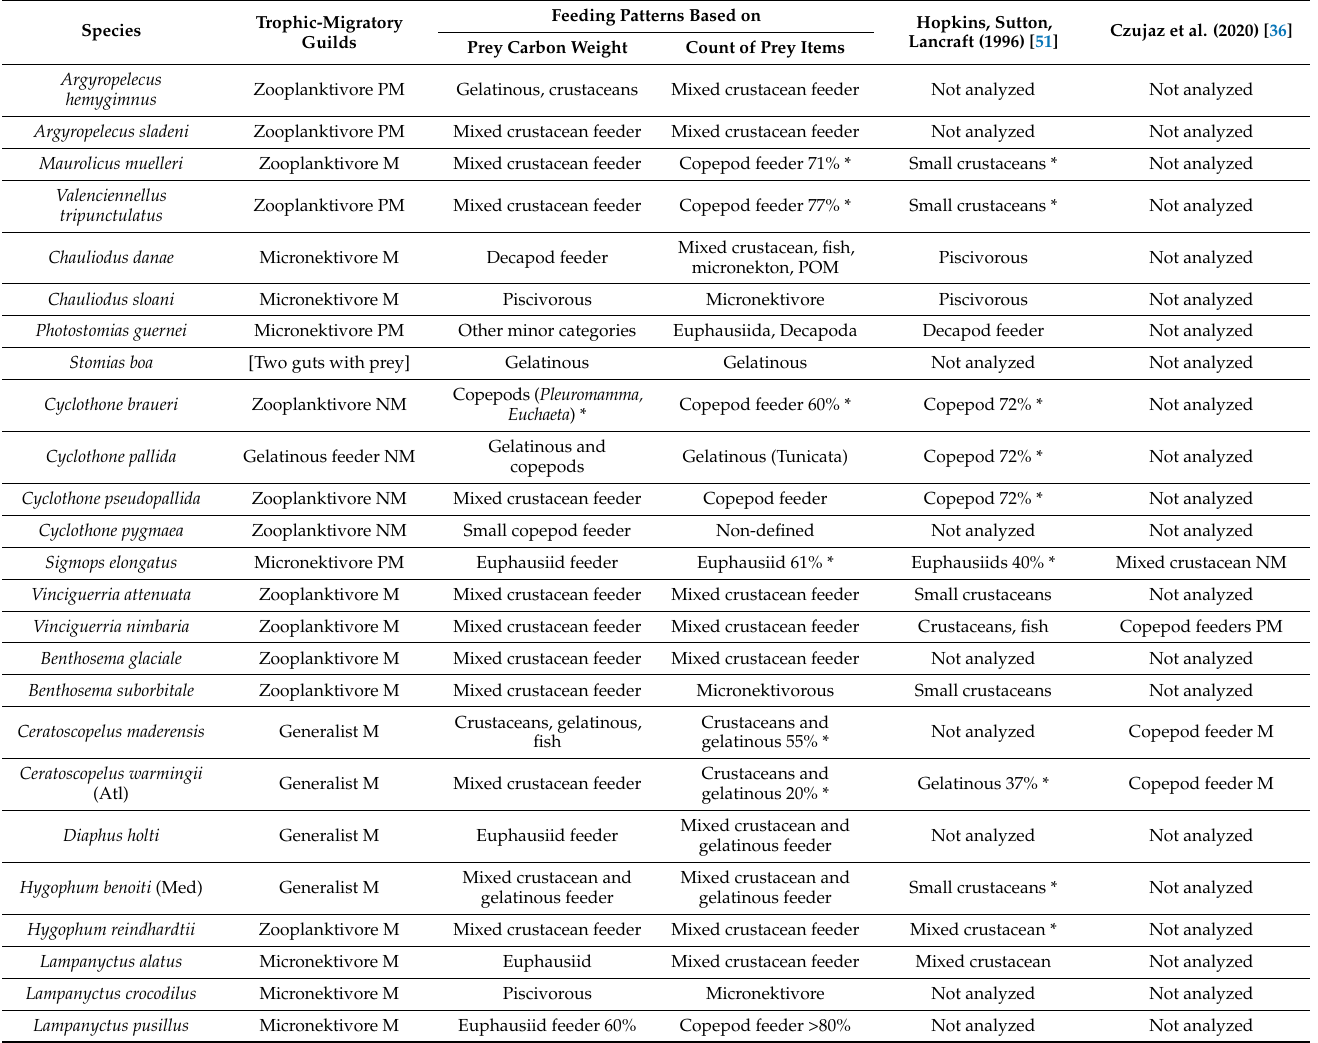
Table 7. Trophic guilds defined for the studied species are presented in combination with their migratory behavior and feeding patterns obtained from the estimation of prey carbon weight and prey abundance. The last two columns correspond to the guilds defined in previous studies [36,51]. M: migrant; PM: partial migrant; and NM: non-migrant. * Predominance of the prey category indicated. ** The species analyzed in the study was the congener L. guentheri , not L. gaussi